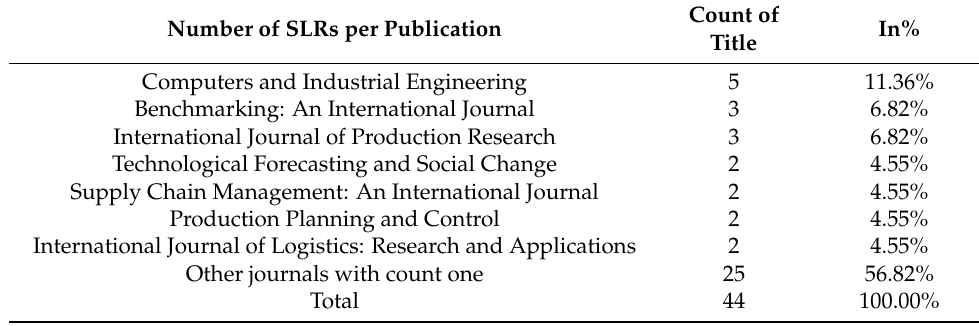
Table 8. Number of SLRs per